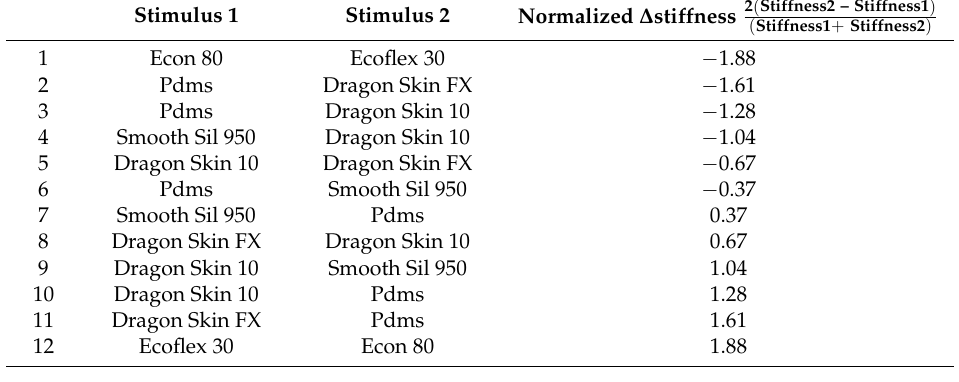
Table 1. Normalized stiffness variations of the selected pairs of stimuli.